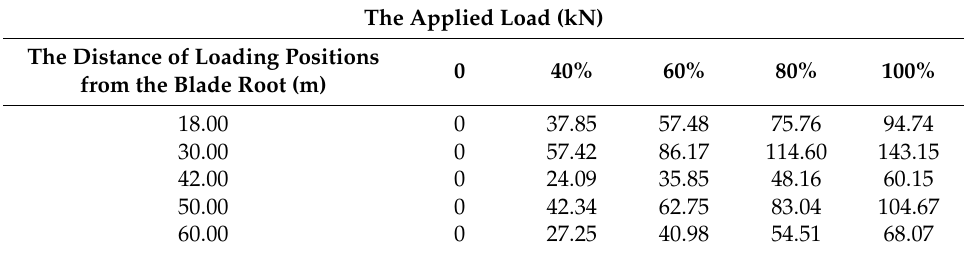
Table 2. The applied load of each stage in flap+.